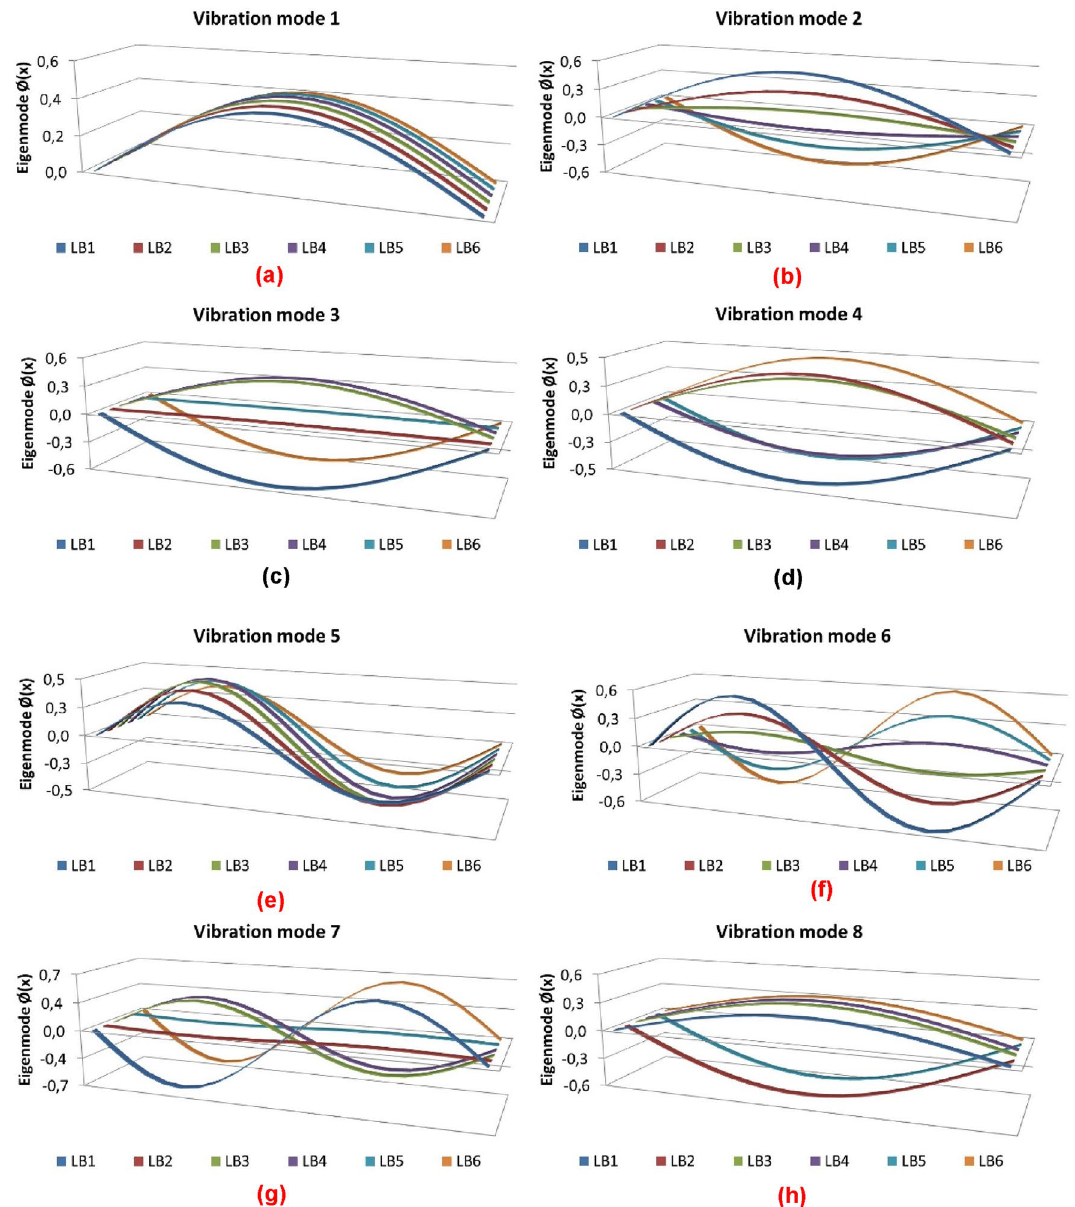
Figure 5. Modal analysis of a girder bridge with 6 longitudinal girders: ( a ) vibration mode 1; ( b ) vibration mode 2; ( c ) vibration mode 3; ( d ) vibration mode 4; ( e ) vibration mode 5; ( f ) vibration mode 6; ( g ) vibration mode 7; ( h ) vibration mode